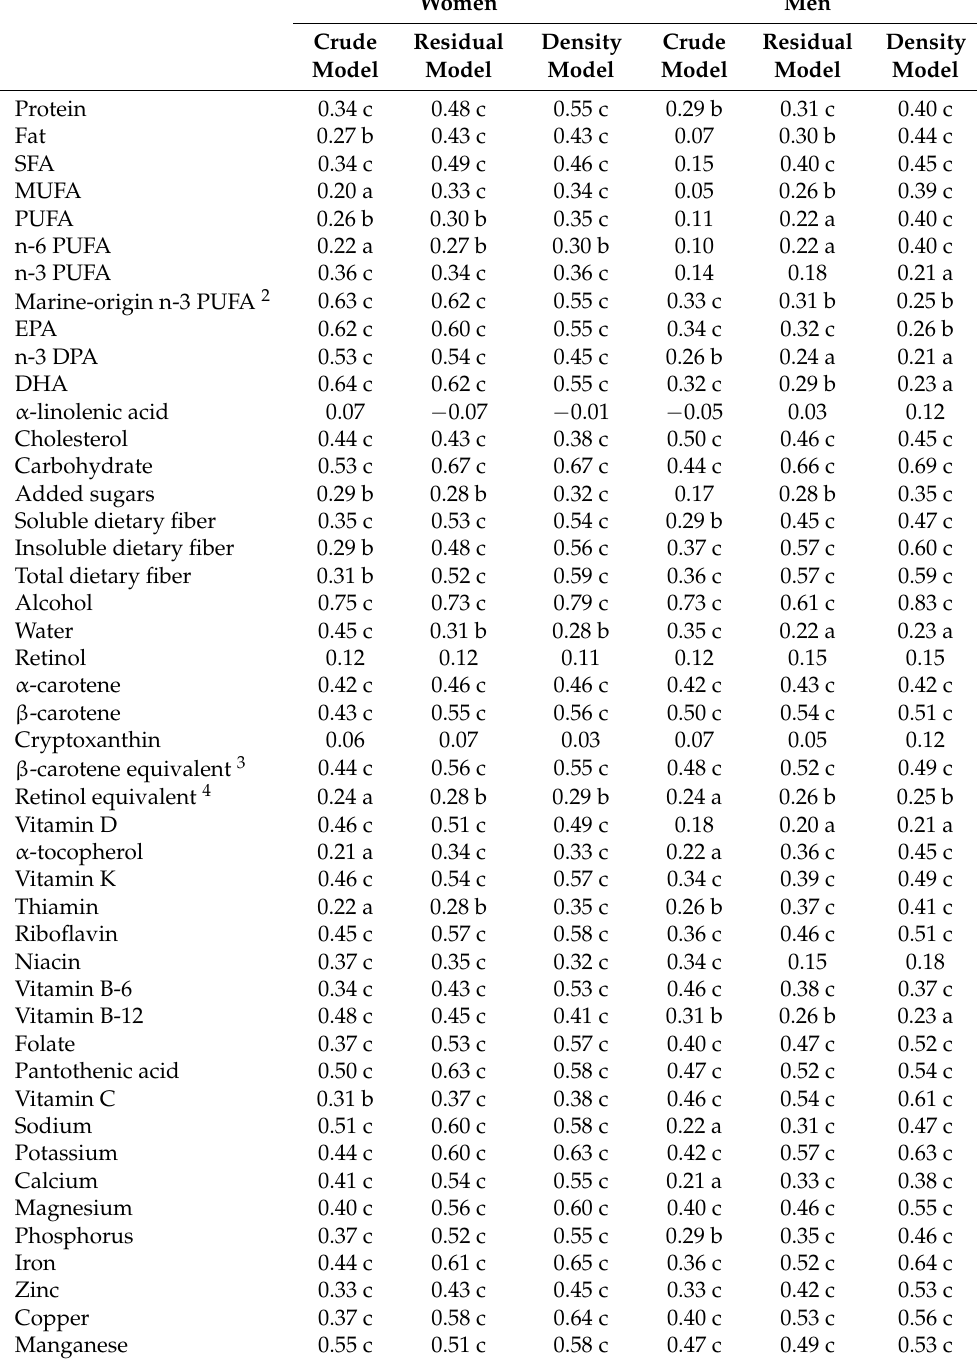
Table 4. Pearson correlation coefficients between crude and energy-adjusted estimates of daily intakes of nutrients obtained from the 4-day weighed dietary record and those obtained from the web version of the Meal-based Diet History Questionnaire in 111 Japanese women and 111 Japanese men 1